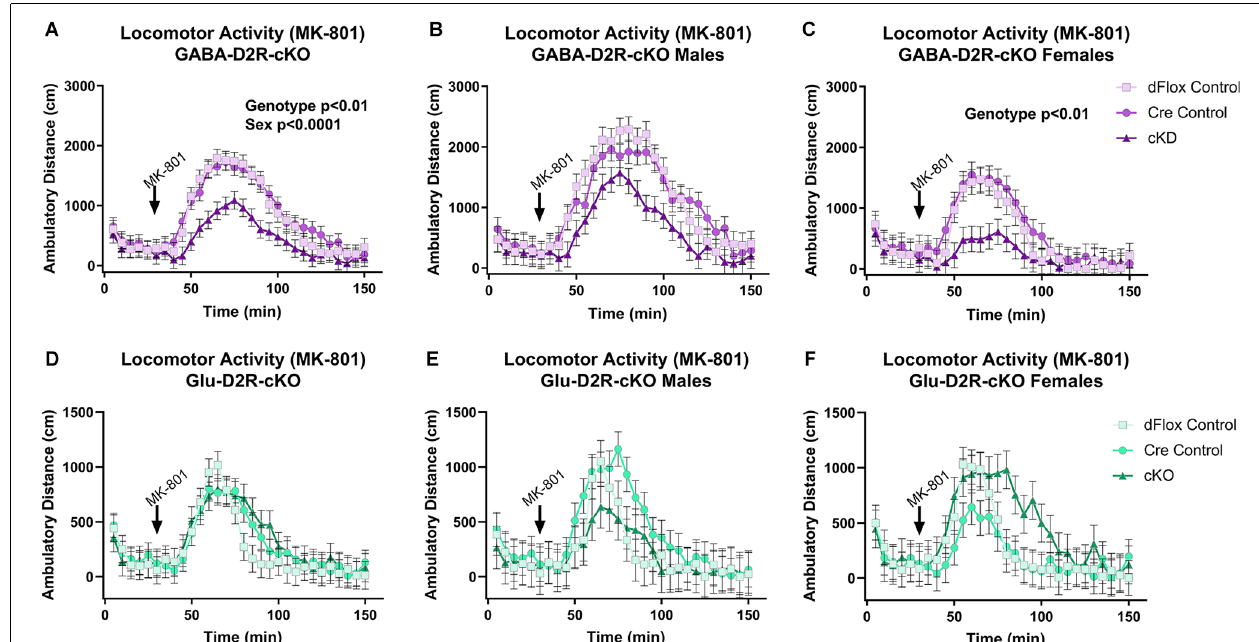
FIGURE 4 | Time course of MK-801-induced locomotor activity in GABA-D2R-cKO and Glu-D2R-cKO mice. MK-801 administration significantly enhanced locomotor activity in the GABAergic (A–C) and glutamatergic (D–F) D2R-cKO and controls, with GABA-D2R-cKO mice demonstrating a significantly decreased activity compared to controls and a significant difference between males and females of the GABA-D2R-cKO line. Data are shown as collapsed across sex (A,D) as well as the activity separately in males (B,E) and females (C,F) . N = 4–7/genotype × sex